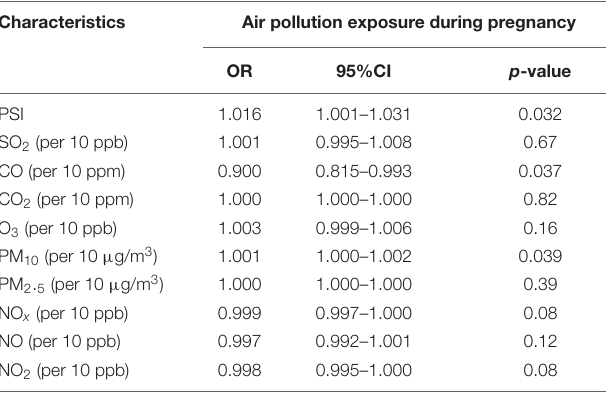
TABLE 3 | Multivariate analysis of factors associated with ITP a .